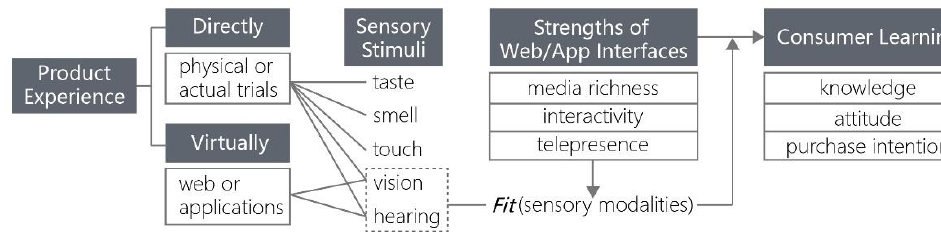
Figure 1. Vision and hearing cues fitting for sensory modalities of Human Machine Interface (HMI) are helpful for the consumers learning about products.